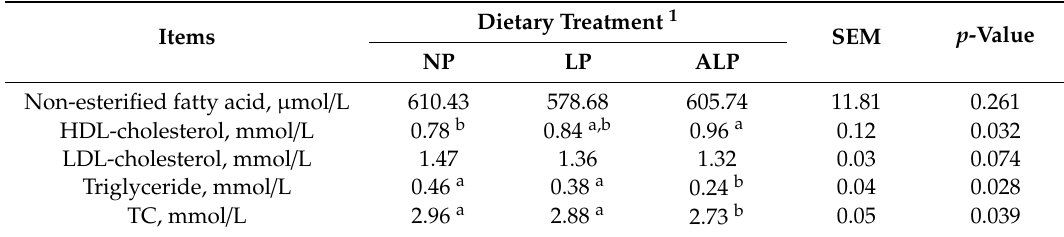
Table 3. Serum lipid-related substances of growing pigs fed normal protein or low-protein diets without or supplemented with AKG.